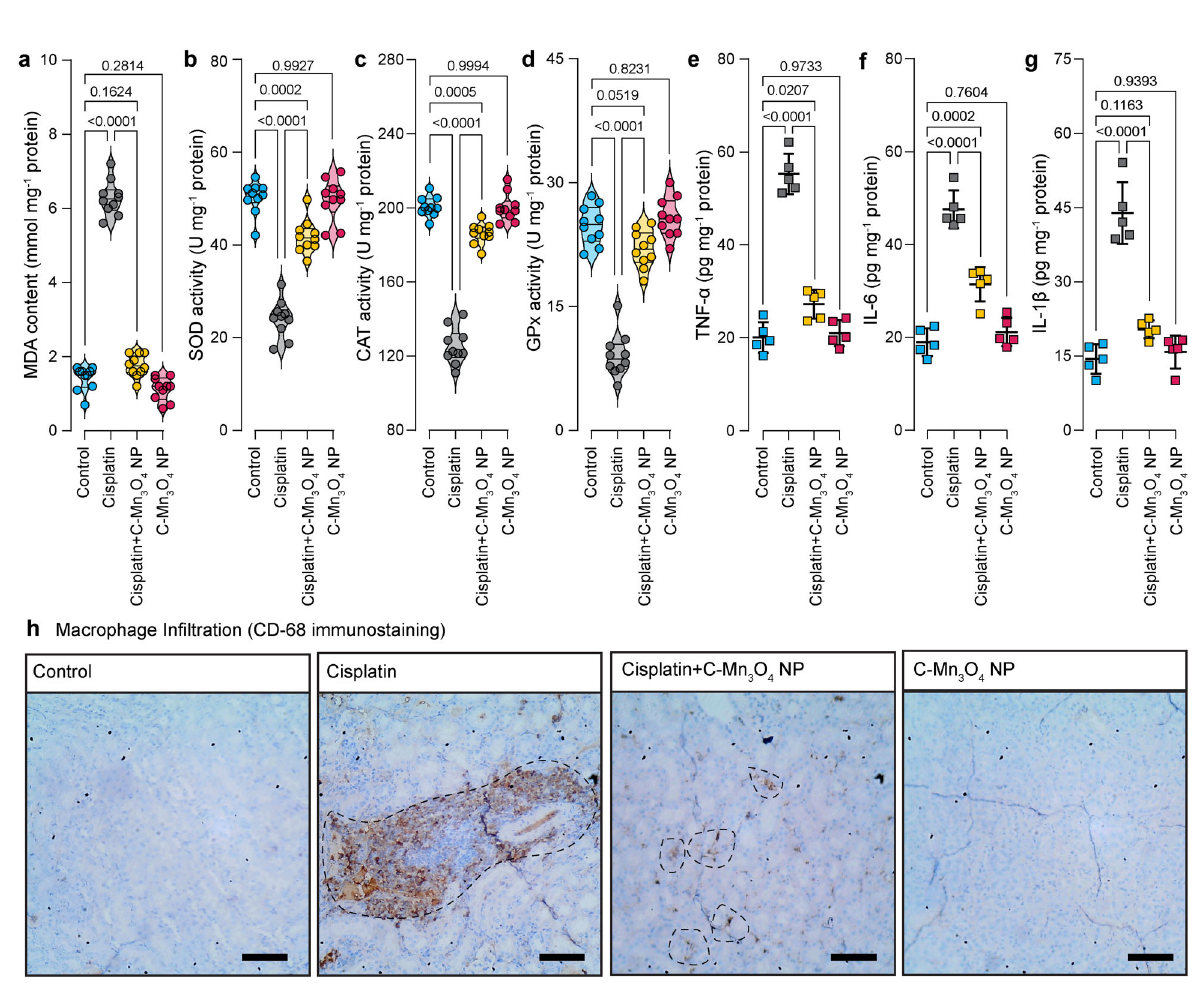
Fig. 5 Effect of C-Mn 3 O 4 NPs in the protection of intracellular redox regulatory network and inhibition of anti-in fl ammatory response in mice. a Extent of lipid peroxidation (MDA, malonaldehyde content) was measured in terms of thiobarbituric acid reactive substances (TBARS). b Superoxide dismutase (SOD) activity. c Catalase activity. d Glutathione peroxidase (GPx) activity. e Tumor necrosis factor- α level. f Interleukin-1 β level. g Interleukin-6 level. h Immunohistochemical analysis of kidney tissues for detection of in fl ammatory damages. Macrophages are stained with anti-CD-68 antibodies (brown). Scale bar: 20 µ m. The dotted circles indicate the regions with high CD68 positivity (i.e., macrophage in fi ltration). MDA, SOD, CAT, and GPx were estimated from kidney homogenate. TNF- β , IL-1 β , and IL-6 were measured from serum. Violins depict kernel density estimation of the underlying data distribution with the width of each violin scaled by the number of observations at that Y-value. Three lines (from the bottom to the top) in each violin plot show the location of the lower quartile (25th), the median, and the upper quartile (75th), respectively. The shaded area indicates the probability distribution of the variable. Individual data points are represented as colored circles ( N = 10). One-way analysis of variance (ANOVA) followed by Tukey ’ s post hoc multiple comparison test was performed for comparison among the groups. The numbers inside the plots indicate numerical p values. p < 0.05 is considered signi fi